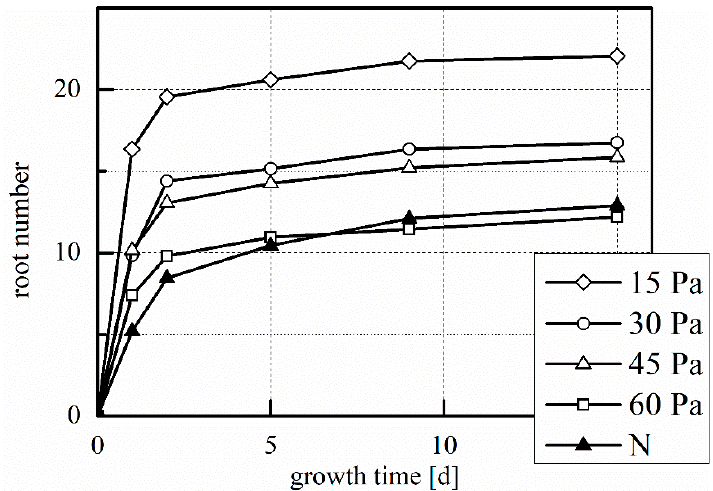
Figure 8. Mean root number during laboratory germination. 15 Pa, 30 Pa, 45 Pa, 60 Pa: plasma treatments at the indicated working pressure; N: untreated control. Number of replications: n = 4 (of five samples each, total 20 samples).